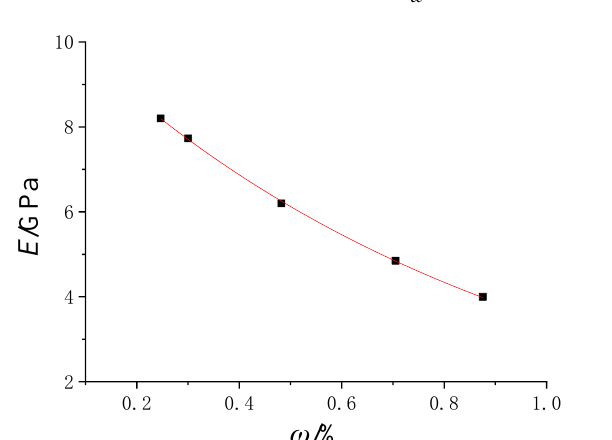
0. 2 Figure 10. The relationship between the elastic modulus and the rock water content. The relationship between Poisson’s ratio and the water content is displayed in Figure 11, which shows that the Poisson’s ratio of the rock increased with the increase in immer- sion time, showing a linear growth relationship. The growth rate was low in the early stage and high in the late stage. The fitting equation is shown in Equation (13) and the correlation coefficient is 𝑅 2 = 0.94088 .